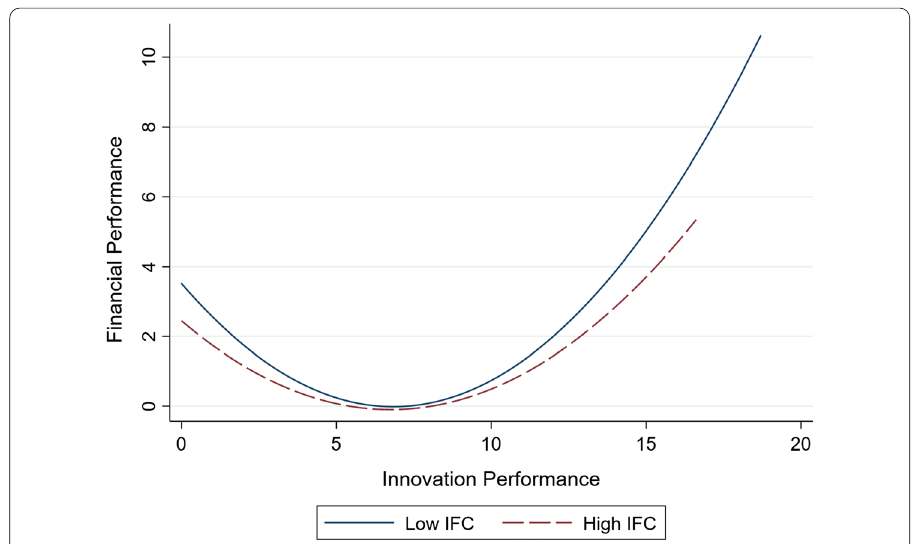
Fig. 2 Relationship between innovation output and financial performance under different levels of individual financial constraints